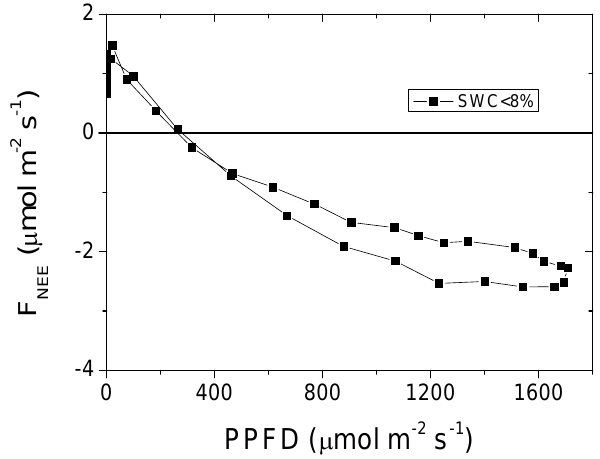
Fig. 6b. Mean hourly NEE flux vs. PPFD for SWC < 8% in 2007. • Page 7, figure caption 6b. The abbreviation PPDF is wrong. It should be written as Clear hysteresis was found for lowest SWC values. NEE flux for PPFD. the lowest values of SWC does not present any increasing relation- • Page 9. We would like to add the sentence: “VR was partly funded by the European ship with temperature (Fig. 6a), however, it does present a clear hys- Social Fund” at the end of the acknowledgement paragraph. teresis cycle indicating that afternoon soil temperature enhancement • Page 10, Monson’s reference. The black box and the words “article number?,” (and soil respiration with it) is not the consequence of should be removed.